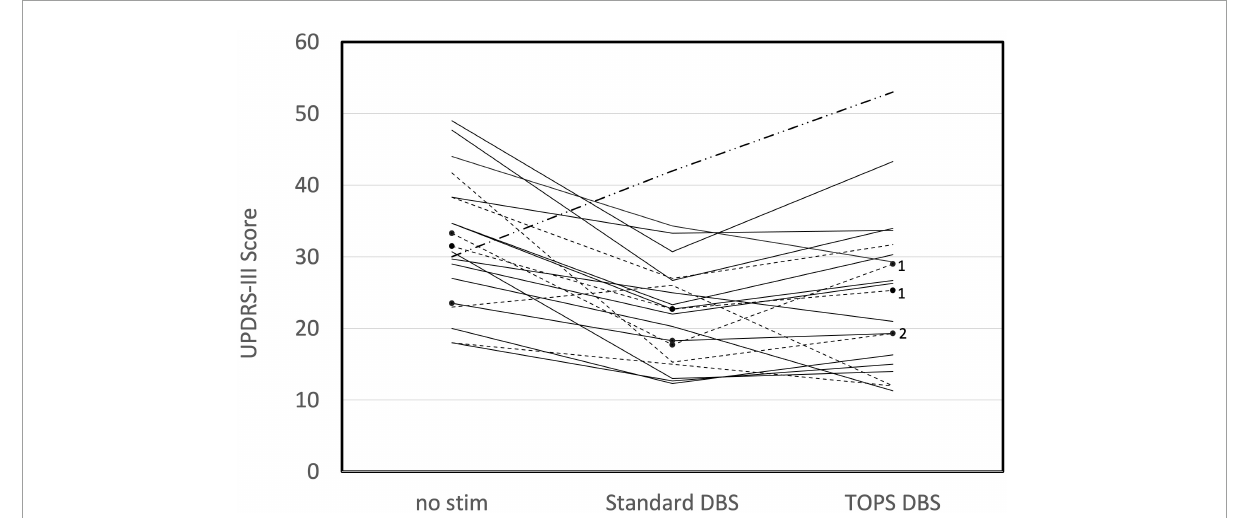
FIGURE1 Motor symptoms, as measured using the UPDRS III in persons ( n = 20) with PD and STN DBS while on their Parkinson’s medications are dependent on the stimulation pattern (One way ANOVA, F = 13.84, p < 0.0001). UPDRS III scores are shown for no stim, standard DBS (sDBS) and the most effective TOPS pattern (TOPS1 or TOPS 2). Patterns were tested with each patient’s stimulation parameters clinically optimized for sDBS. Dotted lines represent subjects in whom TOPS1 was the most effective TOPS pattern. Solid lines represent subjects in whom TOPS2 was the most effective TOPS. Note that TOPS1 and TOPS2 produced equal effects in one subject (B-05), for whom a dash-dot line is displayed. In three subjects, only one TOPS pattern was assessed, and these are marked with black dots and labeled with the pattern tested (TOPS1 = 1 or TOPS2 =